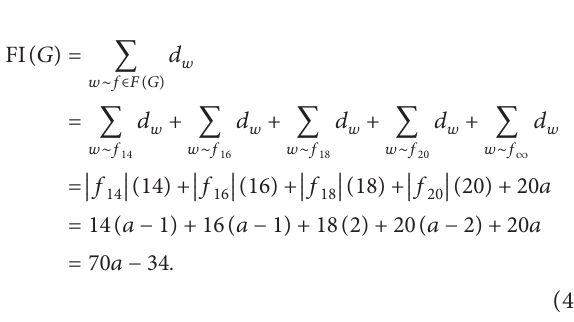
C − II [ 4 , 1 ] , respectively. 2 3 Table 2: Numbers of f